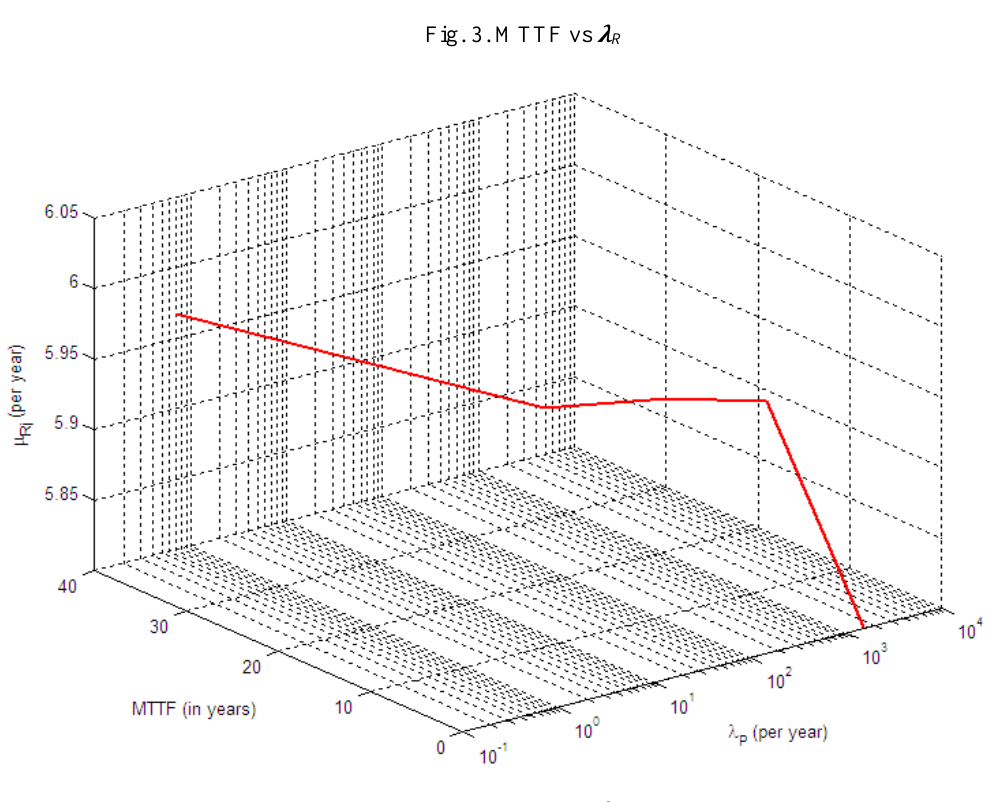
Fig. 4. MTTF vs 𝛌